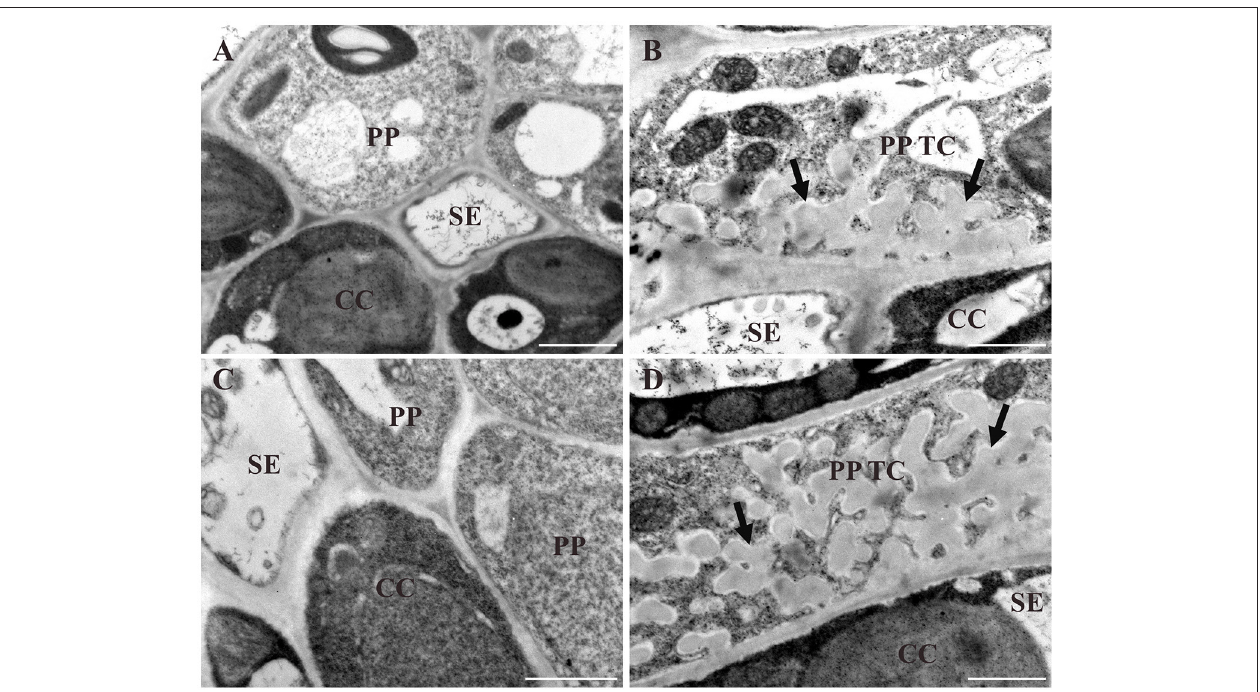
FIGURE 5 | TEM analysis of different stages of wall ingrowth deposition in PP TCs. Wall ingrowths are absent in PP cells of day 5 cotyledons (A) or day 10 juvenile Leaf 1 (C) . By comparison, extensive deposition is seen in PP TCs in day 10 cotyledons (B) and day 16 Leaf 1 (D) . While these ingrowths occupy a substantial volume of the PP TC, their deposition is clearly restricted or focused to the face(s) of the PP TC abutting cells of the SE/CC complex. BS, CC and SE denote bundle sheath cell, companion cell and sieve element, respectively; PP denotes phloem parenchyma cell; PP TC denotes phloem parenchyma transfer cell; arrows indicate deposition of wall ingrowths. Scale bars = 1 µ